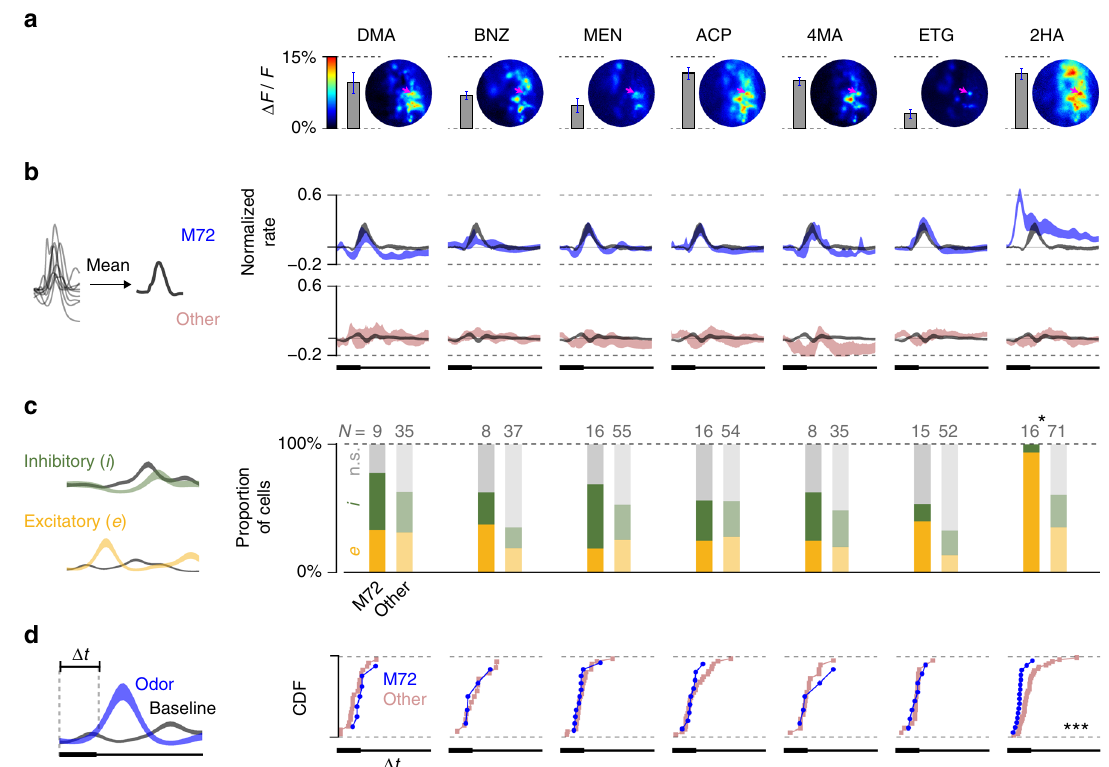
Fig. 4 Response variability/stereotypy across the M72-MT population. a Map of Ca 2 + activity of OSN terminals in the vicinity of M72 glomerulus (magenta arrow) for all odors. Vertical bars indicate the average level of M72 glomerulus activation for each odor. b Mean snif fl et responses. Left (for all following): schematic of measurement. Right: mean normalized snif fl ets for each odor (as in Fig. 3b), averaged across cells. M72-MT cells in blue; generic MT cells in pink; mean baseline snif fl ets in gray. Shaded region denotes ±1SEM. c Polarity of the fi rst signi fi cant response. Right: histograms of fi rst response polarity (yellow: excitatory; green: inhibitory; gray: no signi fi cant rate change) for M72-MT cells (left bar; bold) and generic MT cells (right bar; desaturated). Statistical tests: Pearson ’ s chi-squared, comparing number of excitatory/inhibitory responses for M72 and generic cells (here and further: * p < 0.05; ** p < 0.01; and *** p < 0.001). d Latency to fi rst signi fi cant response. Signi fi cance is measured as a 3 σ difference between the odor-evoked snif fl et and the baseline snif fl et. Right: cumulative distribution functions (CDFs) of response latencies among the M72-MT (blue) and generic MT (pink) populations. Cells for which odor-evoked activity did not signi fi cantly deviate from baseline are omitted. For all odors except 2HA (last column), there is no signi fi cant difference between the latency distributions of the M72-MT population and of the generic MT population (Kolmogorov – Smirnoff two-sample